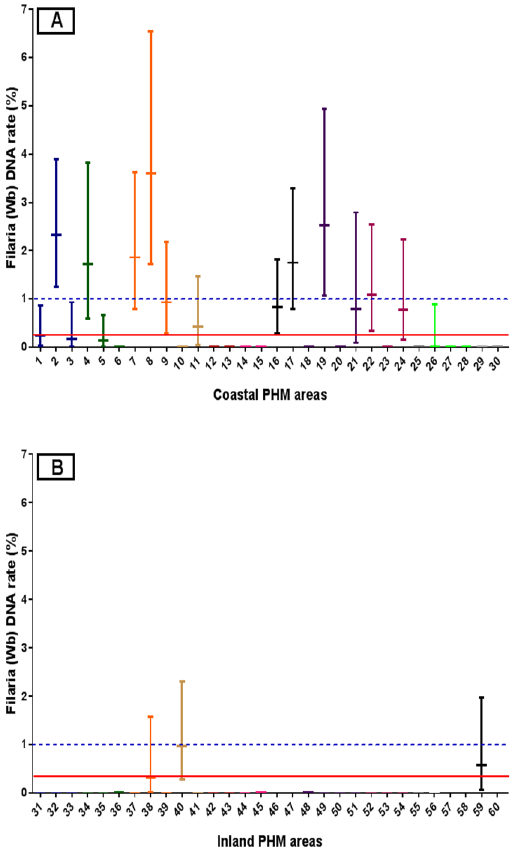
Fig 1. Filarial DNA rates (MLE with 95% confidence intervals) for mosquitoes collected in the coastal (panel A) and inland (panel B) EUs in Galle district. Lines with the same color show results from PHMs within a single MOOH area. Filarial DNA rates exceeded the target rate of 0.25% in 16 of 60 PHMs, and the upper confidence limit exceeded the target of 1% in all these 16 PHMs. The solid line in the panel A and B show the provisional target for MX. The dotted lines in the two panels are at the recommended upper confidence limits for filarial DNA rates in mosquitoes.